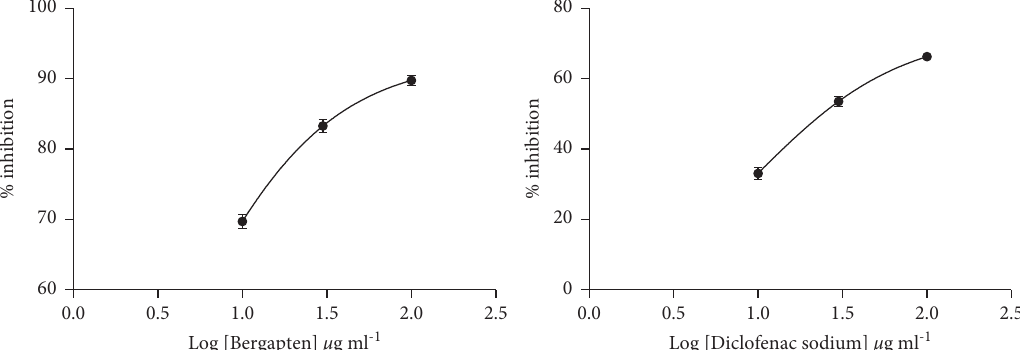
Figure 2: Dose-response curves for bergapten and diclofenac sodium in heat-induced hemolysis. The negative control consisted of 1.0ml of 10% erythrocyte suspension and 1.0 ml of normal saline alone. Data were presented as mean ± standard error of mean